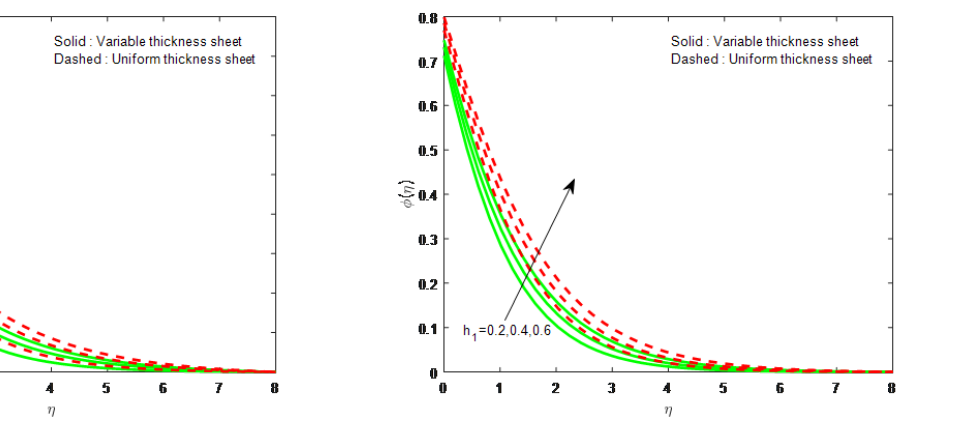
Fig. 13: Influence of β on concentration field